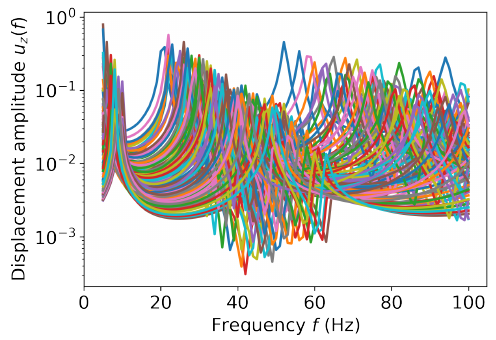
Figure 4. Overview of z -component displacement amplitude profiles, with visible variations among all 100 configurations in database. Each curve here represents for one